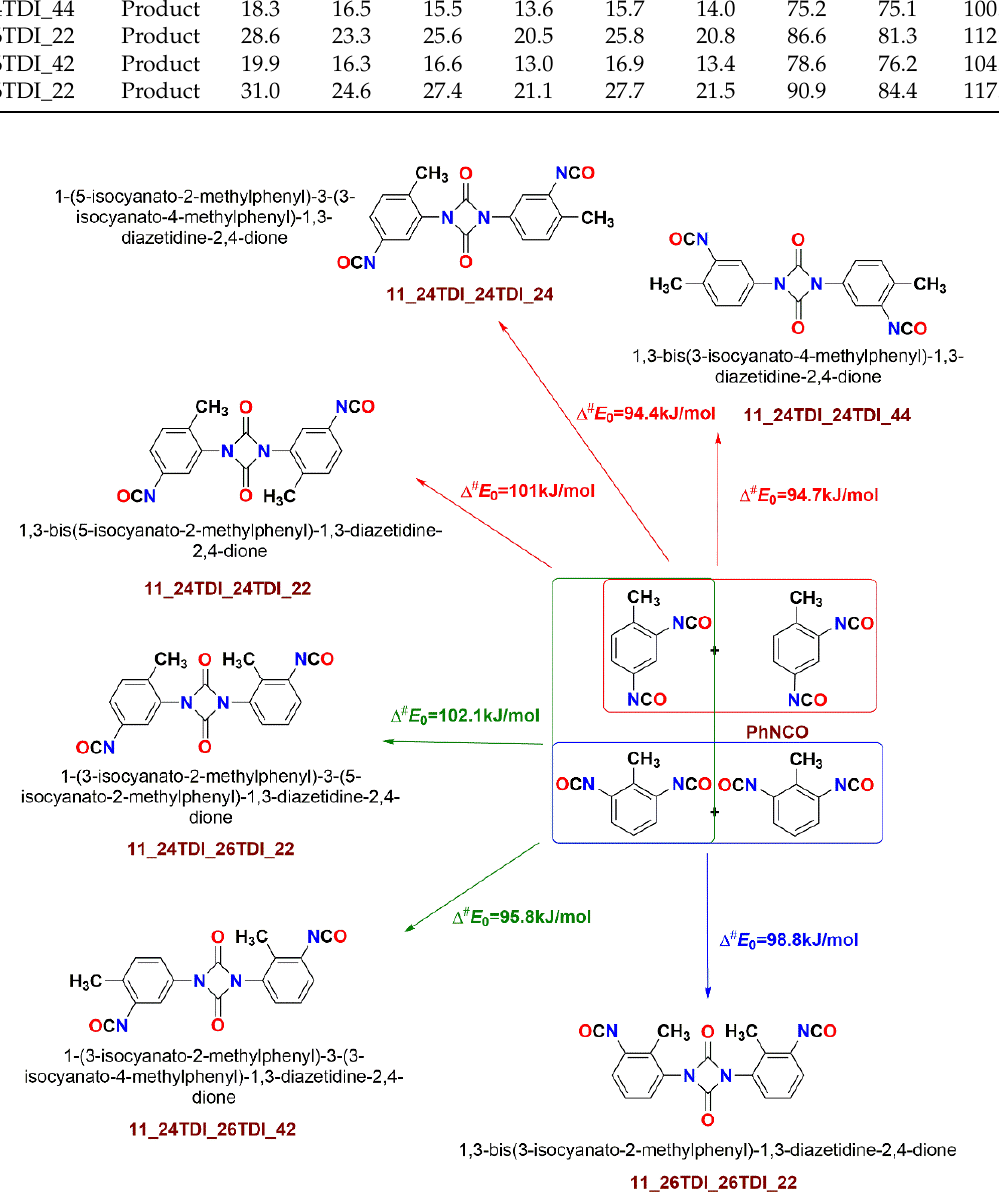
Figure 2. Reaction scheme for the dimerization of TDI isomers via homocyclization leading to diazetidines. The gas-phase activation energies ( Δ # E 0 ) were computed according to the G3MP2B3 protocol. Table 1. G3MP2B3 thermochemical properties calculated in the gas phase and in ortho-dichloro-